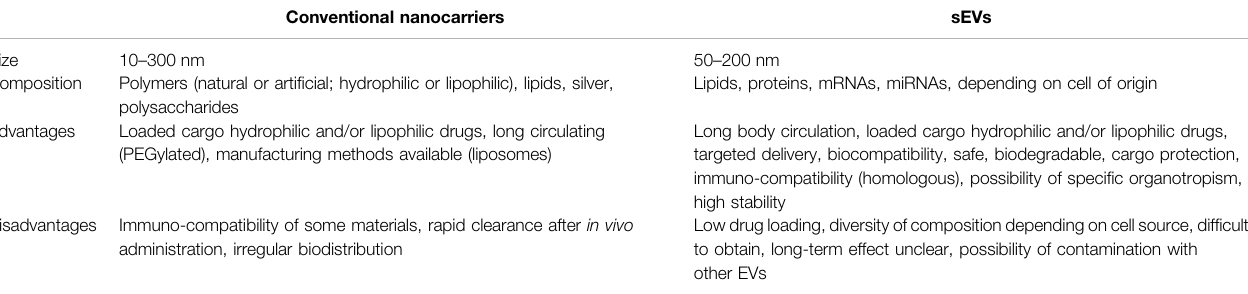
TABLE 2 | Main differences between conventional nanocarriers and small extracellular vesicles (sEVs) as drug delivery